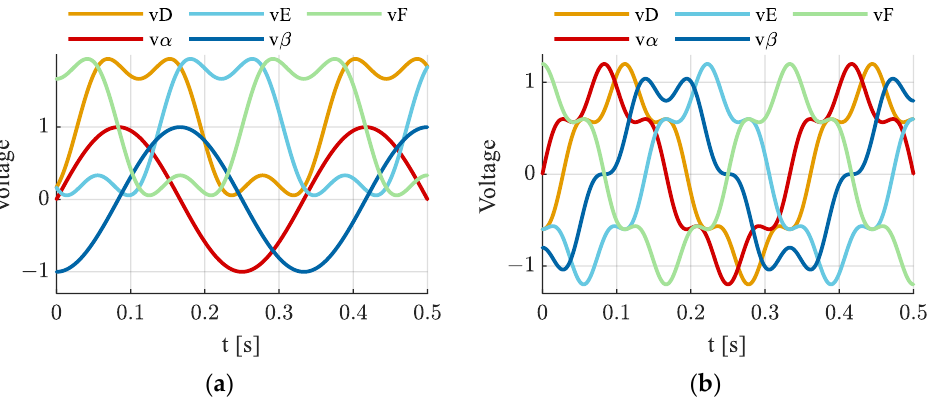
Figure 4. Simulation of the transformation between phase coordinates D – E –F to the stationary α–β subspace at the zero-position reference frame: ( a ) basic harmonic with the third harmonic and the DC offset; ( b ) basic harmonic with the fifth harmonic.